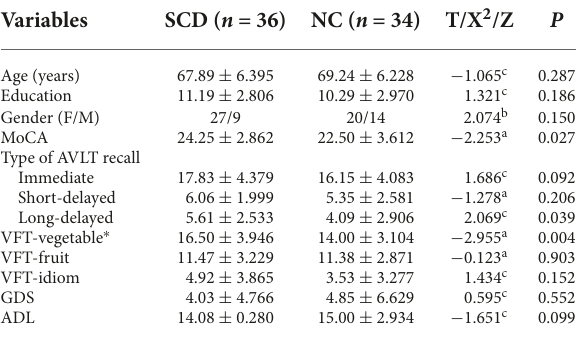
TABLE 1 Demographic and neurocognitive characteristics of the NC and SCD groups.